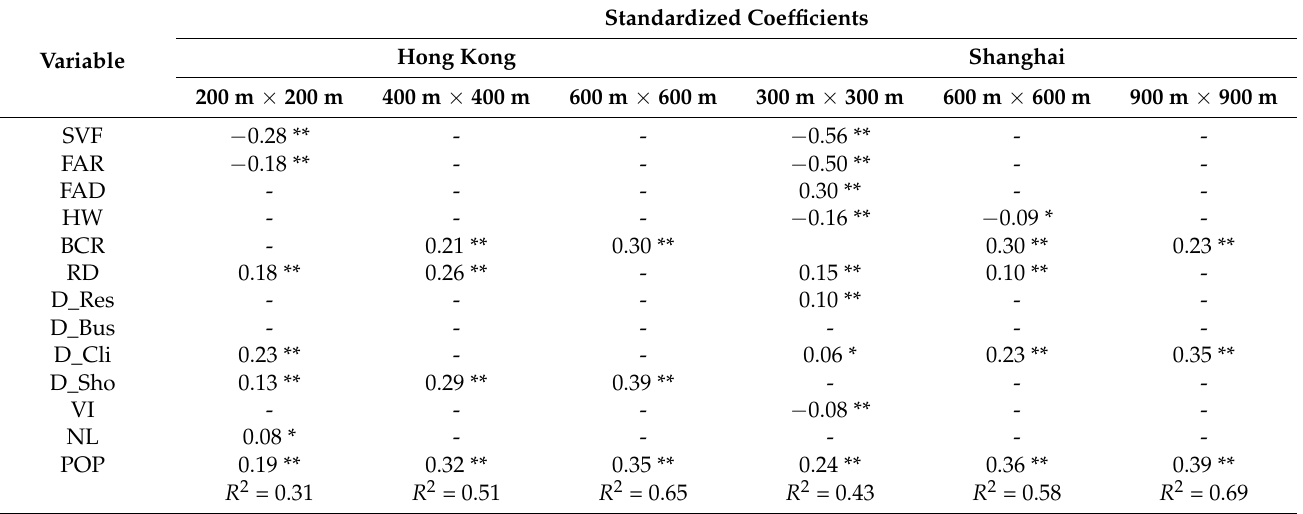
Table 4. Stepwise regression results at different spatial scales for Hong Kong and